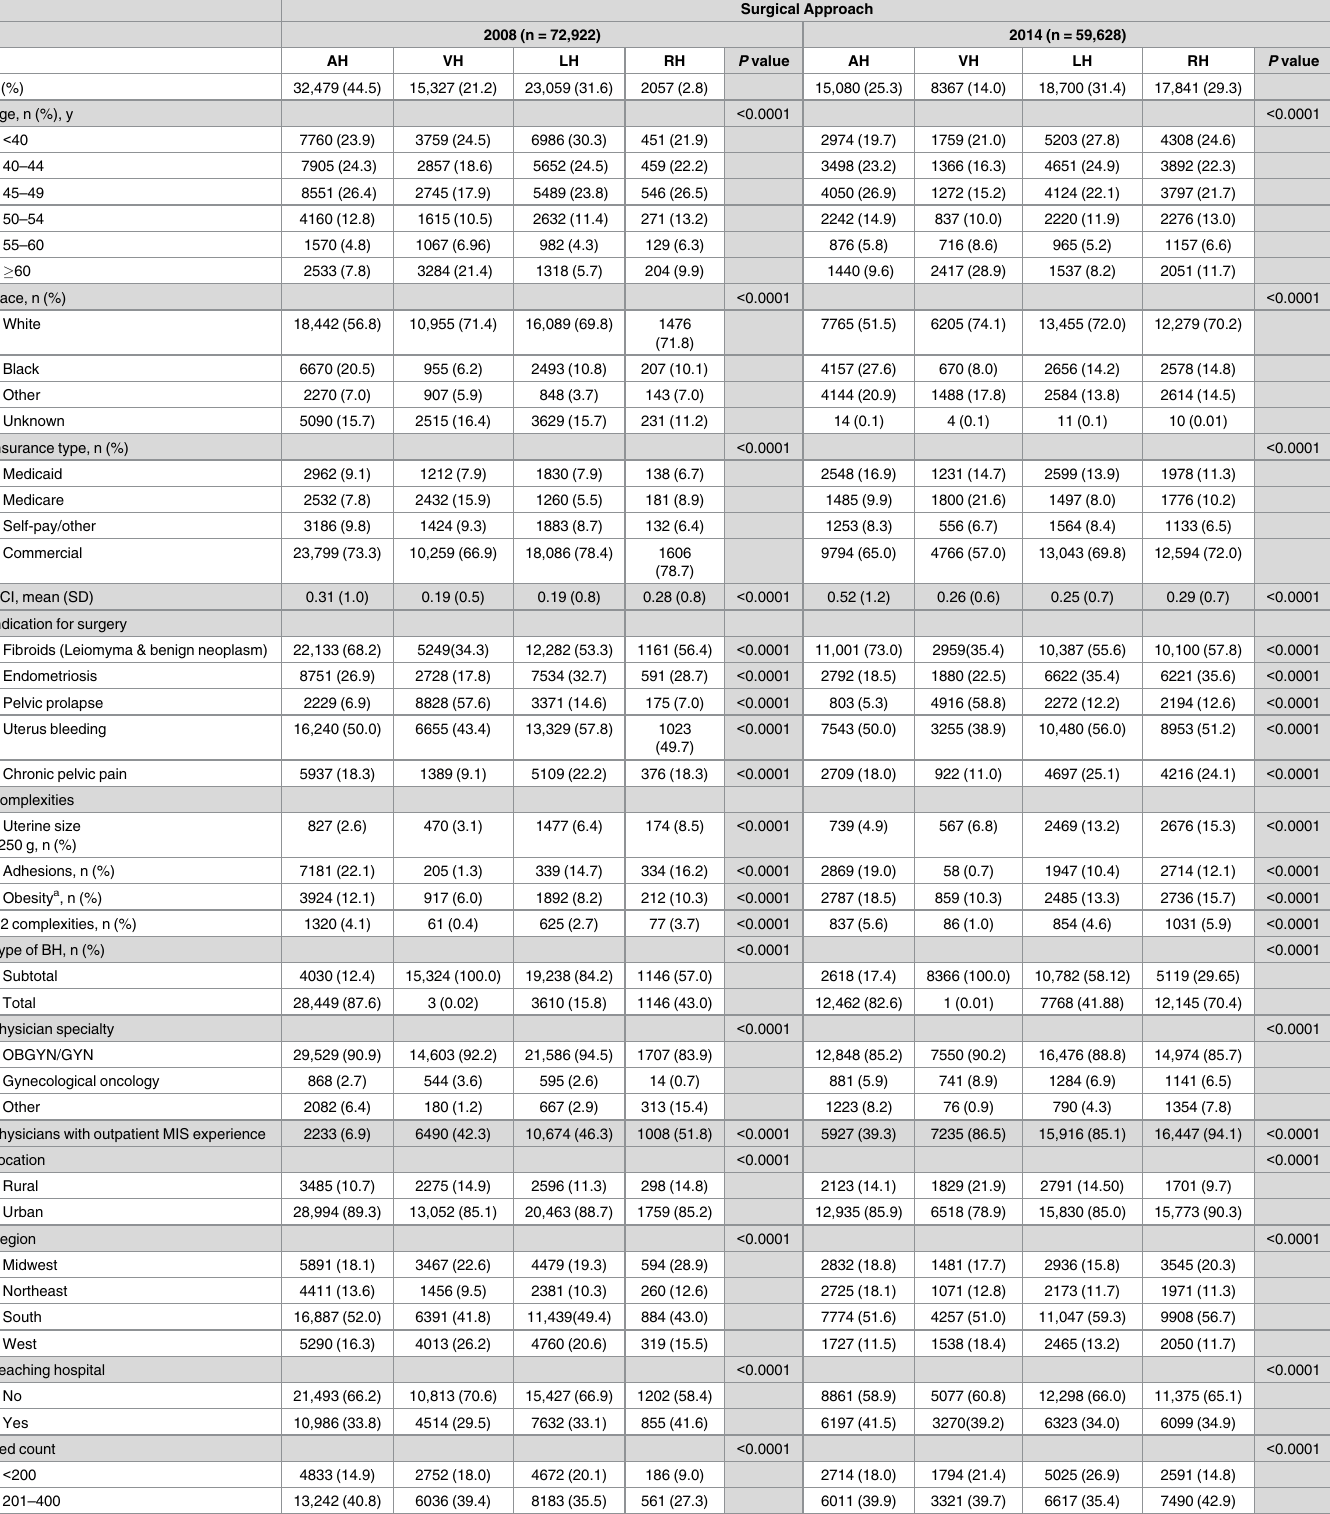
Table 1. Patient characteristics for benign hysterectomy performed in 2008 and